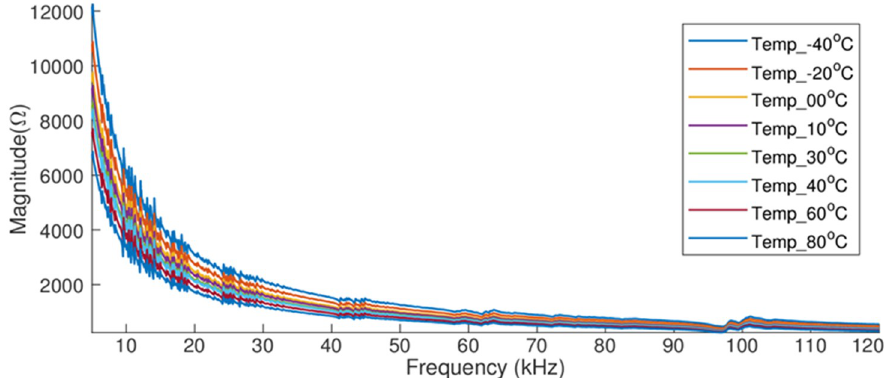
Figure 4. pipe-1/PZT-1 electrical impedance signatures under the effect of temperature. Figure 4. pipe-1 / PZT-1 electrical impedance signatures under the e ff ect of